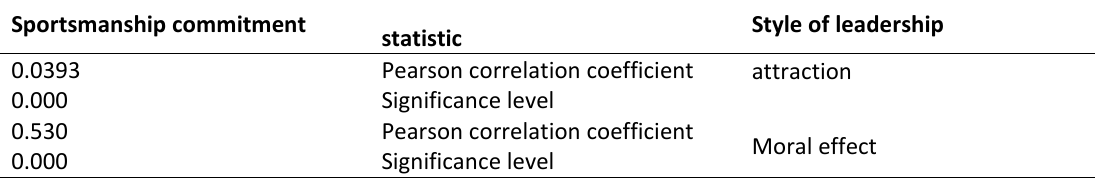
Table 8. Pearson, Spearman test results ; correlations between commitment and different leadership